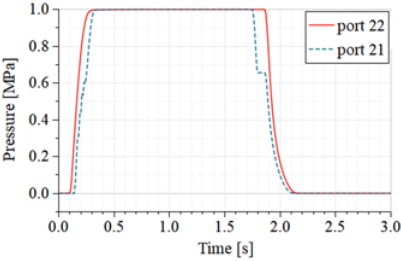
Figure 12. Characteristic curves of series dual ‐ chamber air brake valve. The port 21 is connected to the relay valve control port. The port 22 is connected to the front ABS pressure regulators’ inlets.